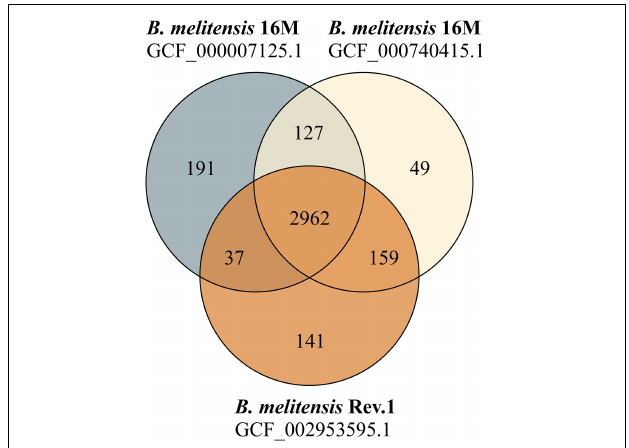
FIGURE 1 | Venn diagram of shared and unique protein sequences found in RASTtk-annotated genomes. The protein-coding sequence sets of two B. melitensis 16M genomes (GCF_000007125.1: 3317 CDS; GCF_000740415.1: 3297 CDS) and one B. melitensis Rev.1 genome (GCF_002953595.1: 3299 CDS) were